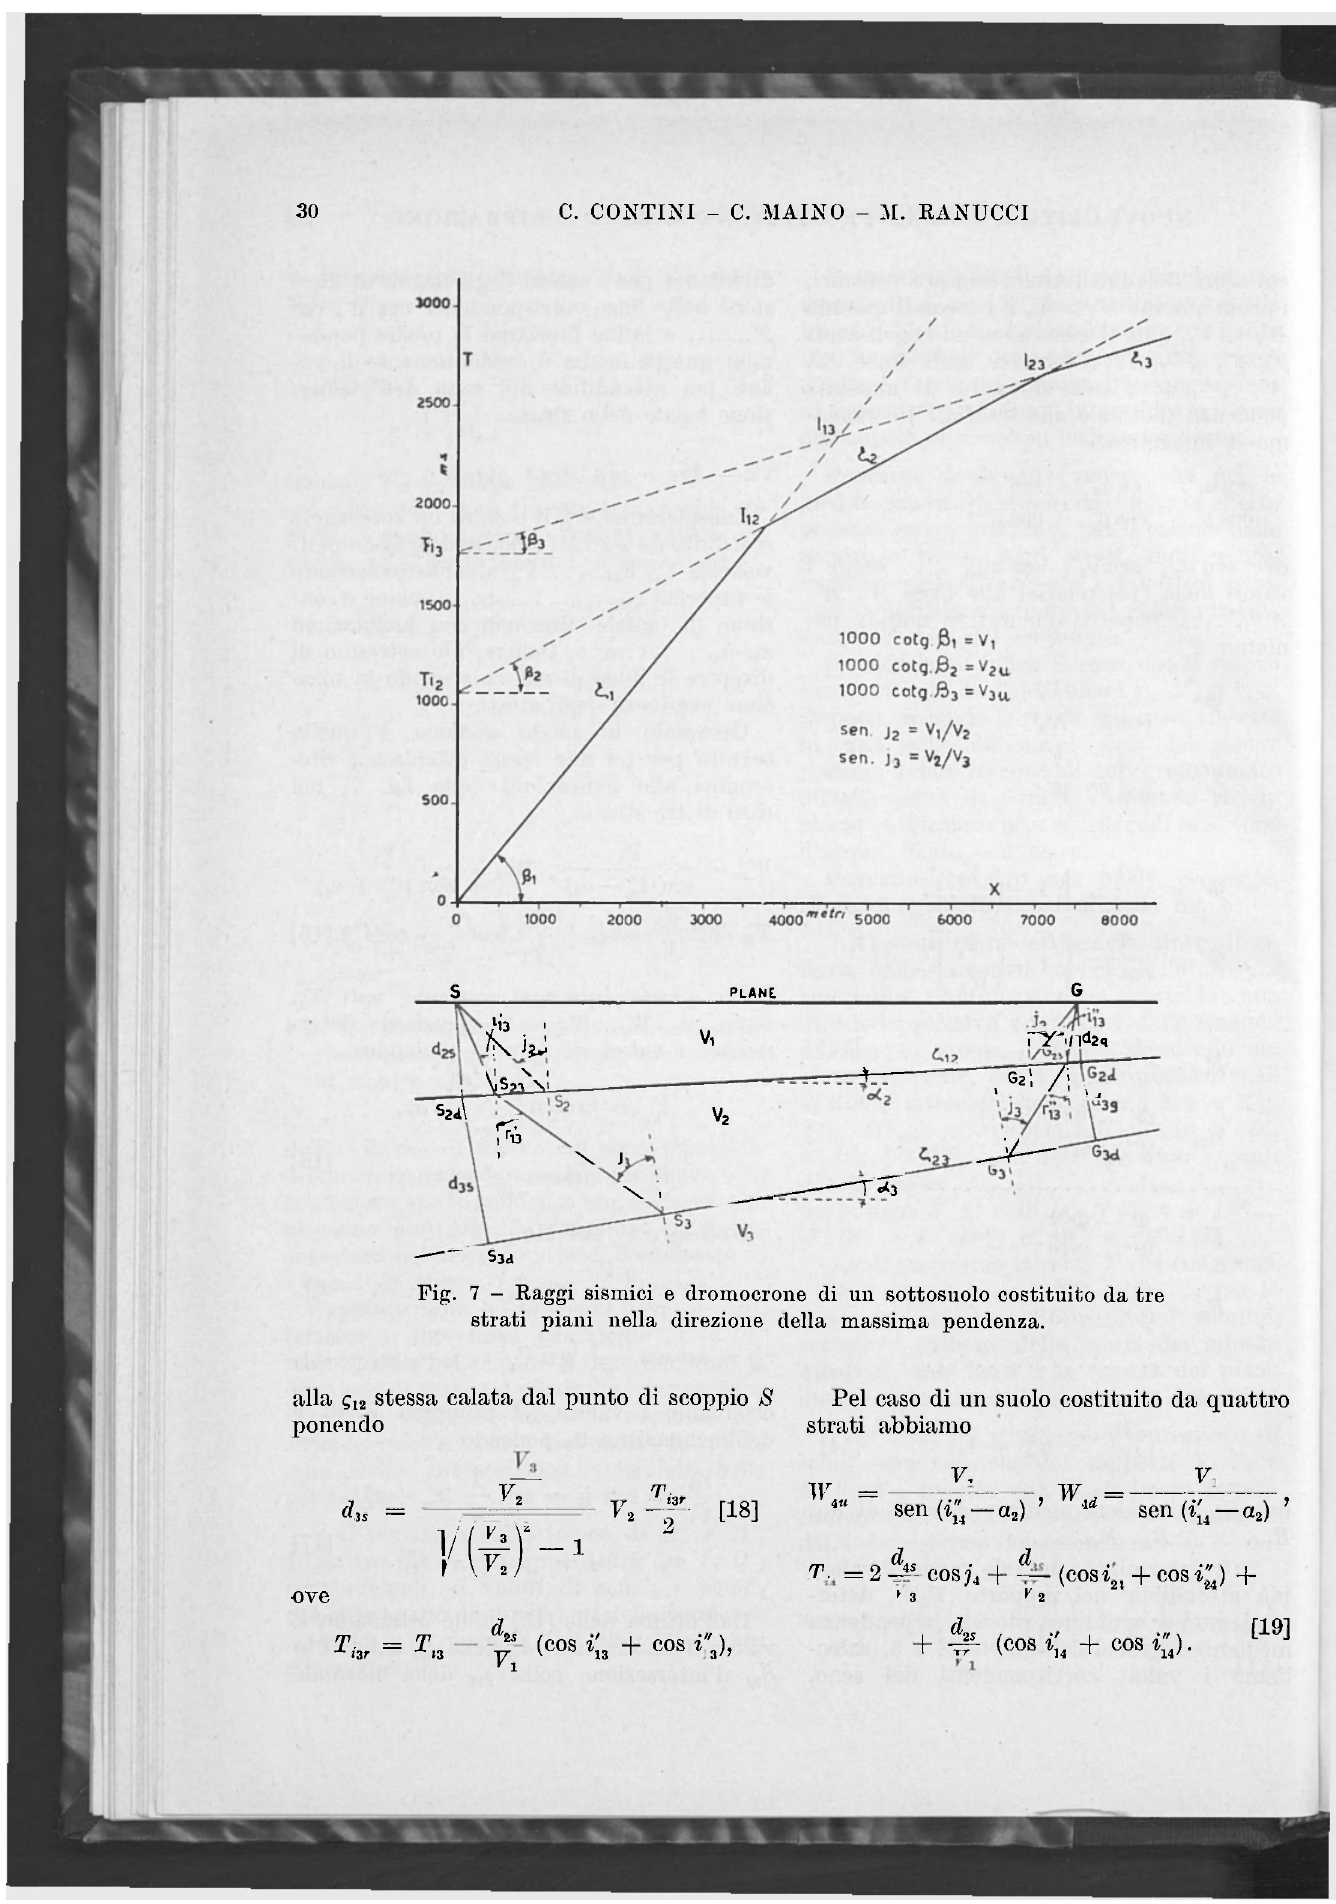
Fig. 7 - Raggi sismici e dromocrone di un sottosuolo costituito da tre strati piani nella direzione della massima